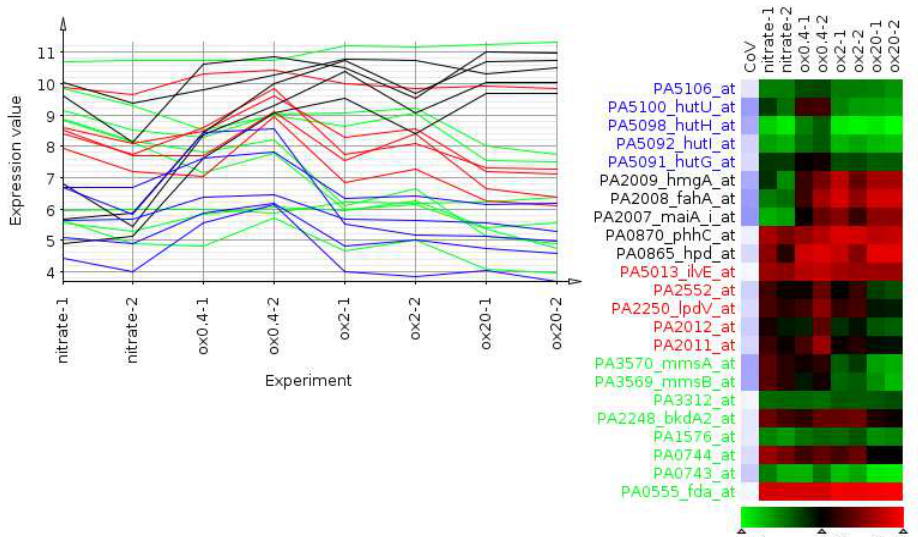
Figure 5: Profile plot (left) and enhanced heatmap (right) showing genes involved in histidine (blue), tyrosine (black), leucine (red) and valine (green) degradation. The heatmap additionally displays the coefficient of variation as a column using a blue